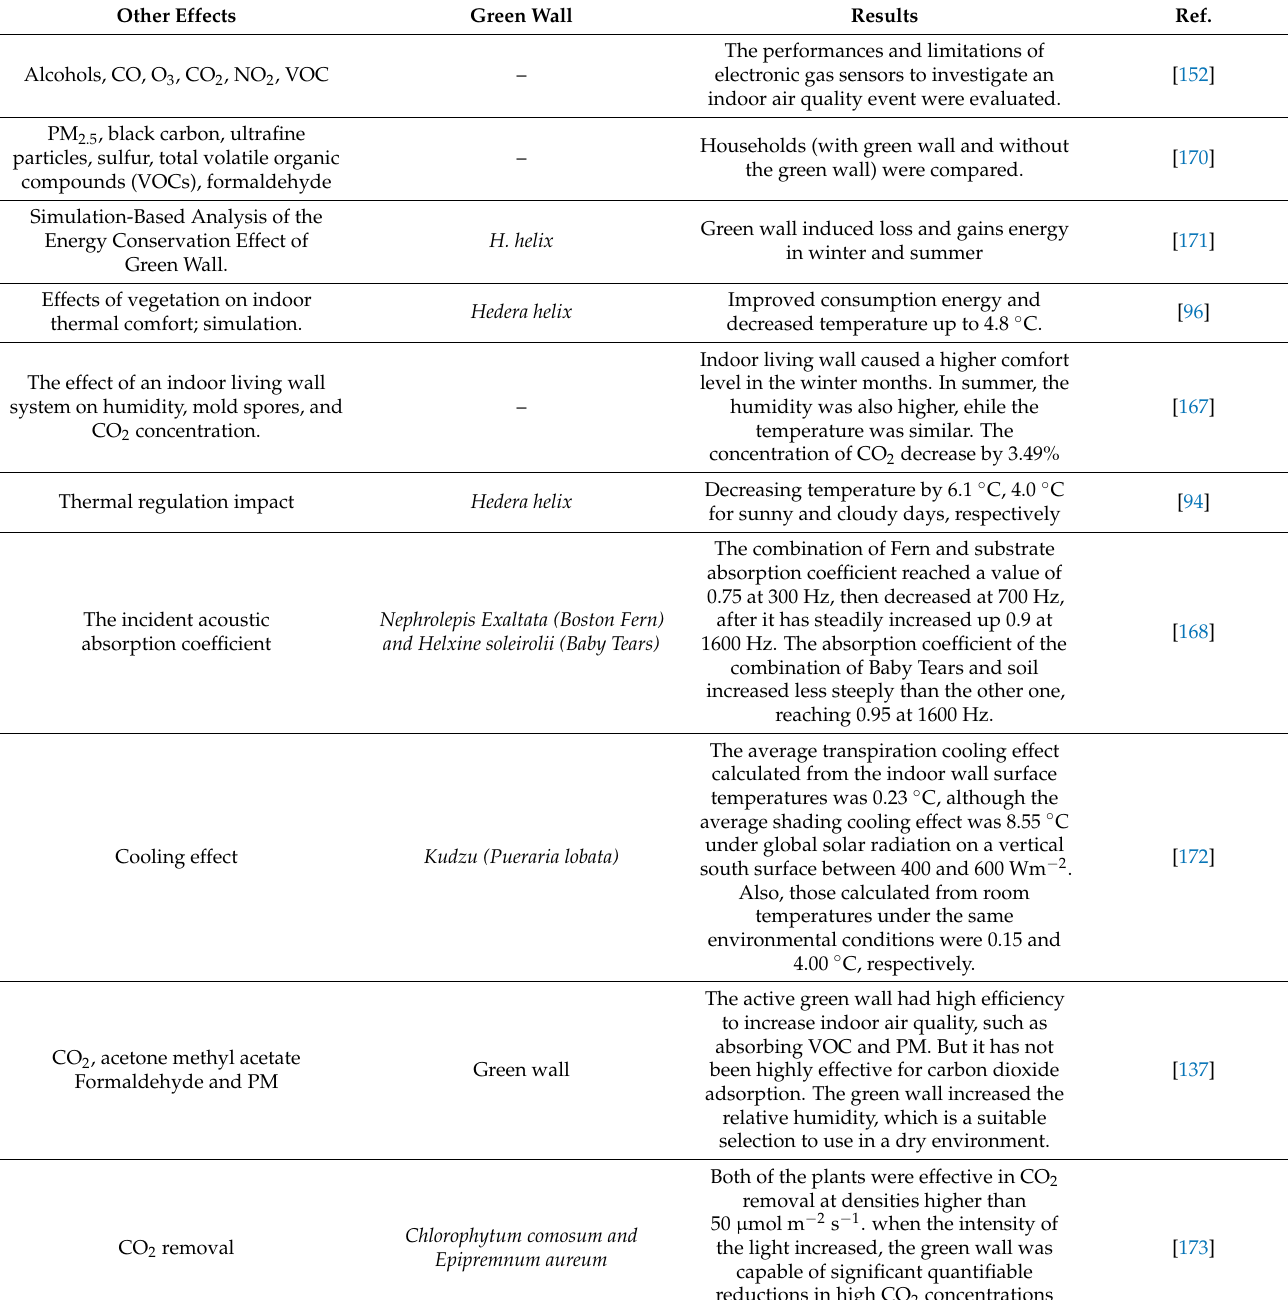
Table 4. Research on indoor air cleaning organized based on other effects of a green